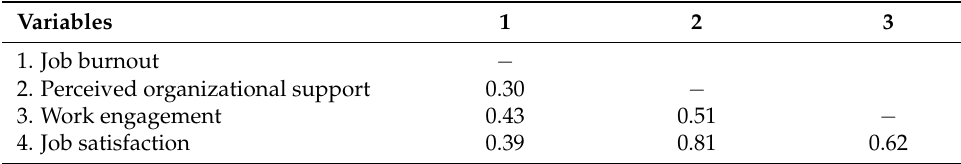
Table 6. Heterotrait–monotrait (HTMT) discrimination validity.